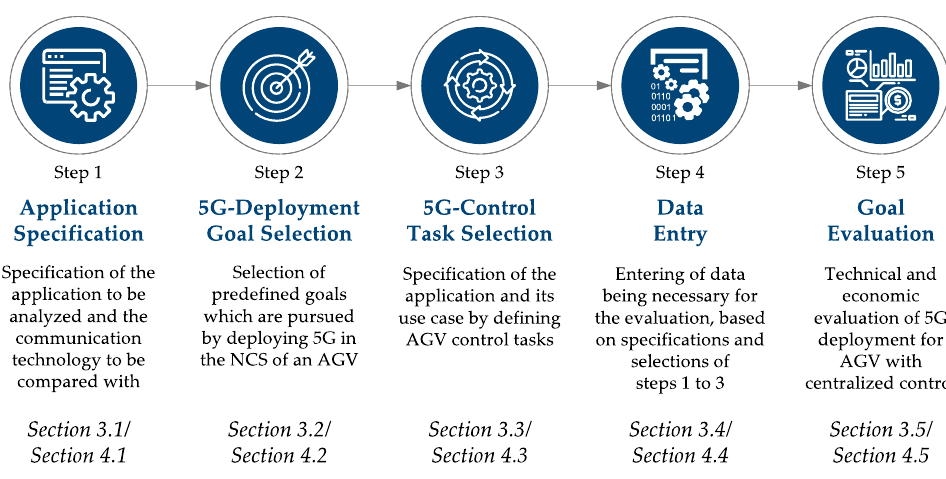
Figure 5. Chapter structure and evaluation approach for techno-economic evaluation of 5G technol- ogy for AGV according to [44] .